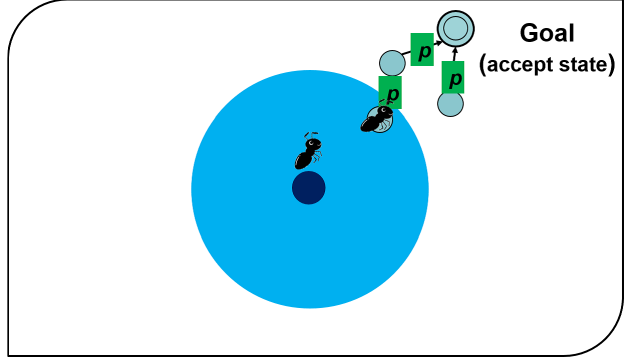
Figure 4. Diffusing of smell